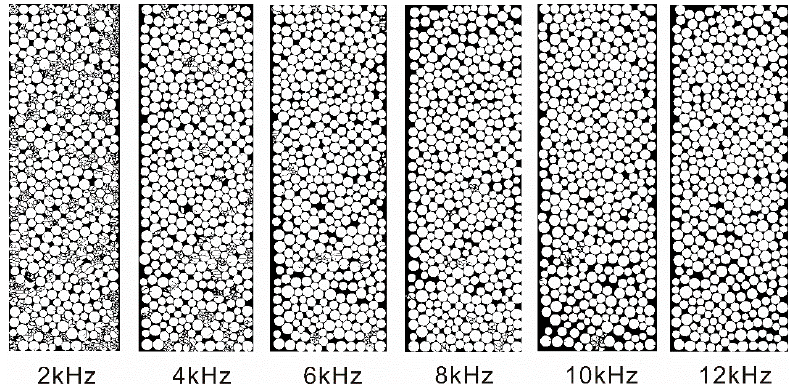
Figure 11. The configuration change of the filled particles after loading by the stress waves with different frequencies.